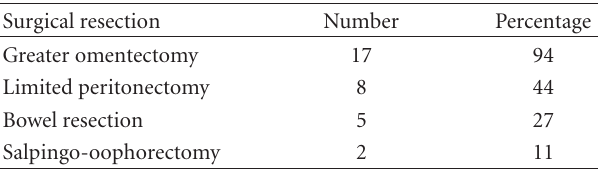
Table 3: Procedures performed in 18 patients undergoing laparo- scopic